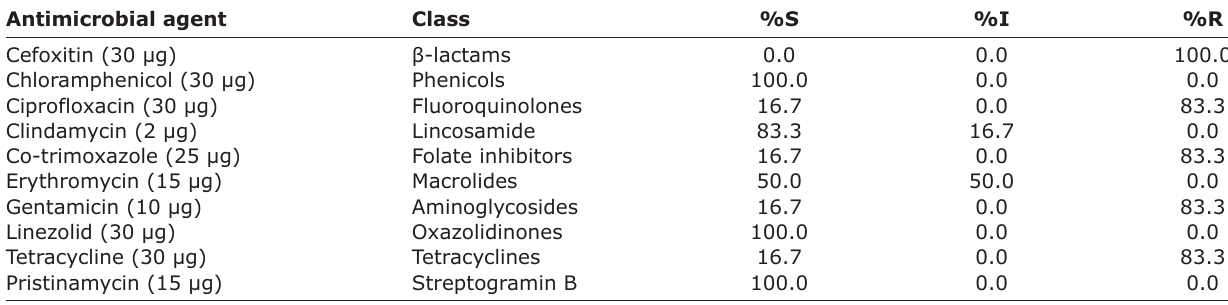
Clindamycin (2 µg) Lincosamide Co-trimoxazole (25